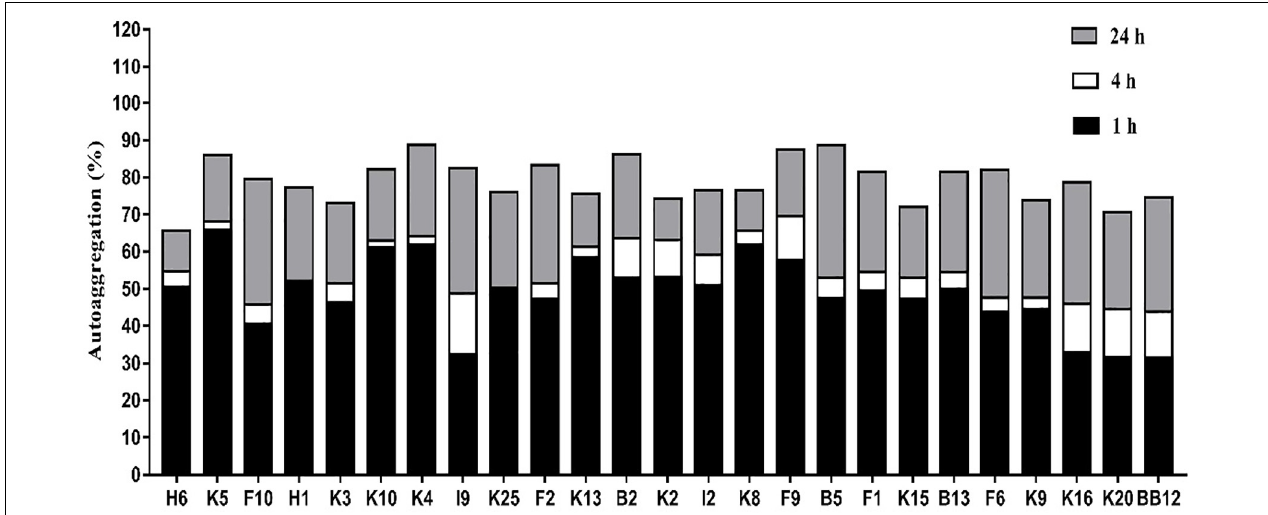
FIGURE 4 | Autoaggregation of B. longum subsp. longum strains at 1h, 4h, and 24 h.